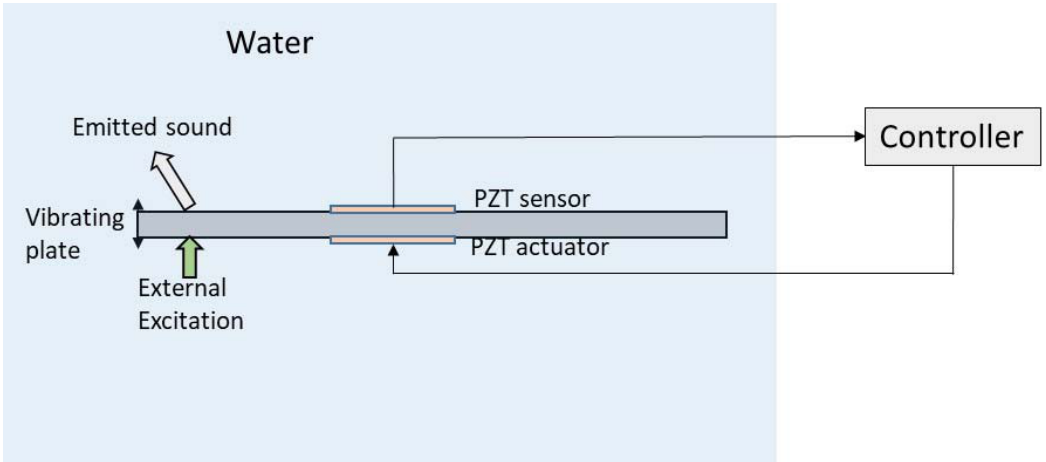
Figure 3. Active vibration control with a PZT sensor and PZT